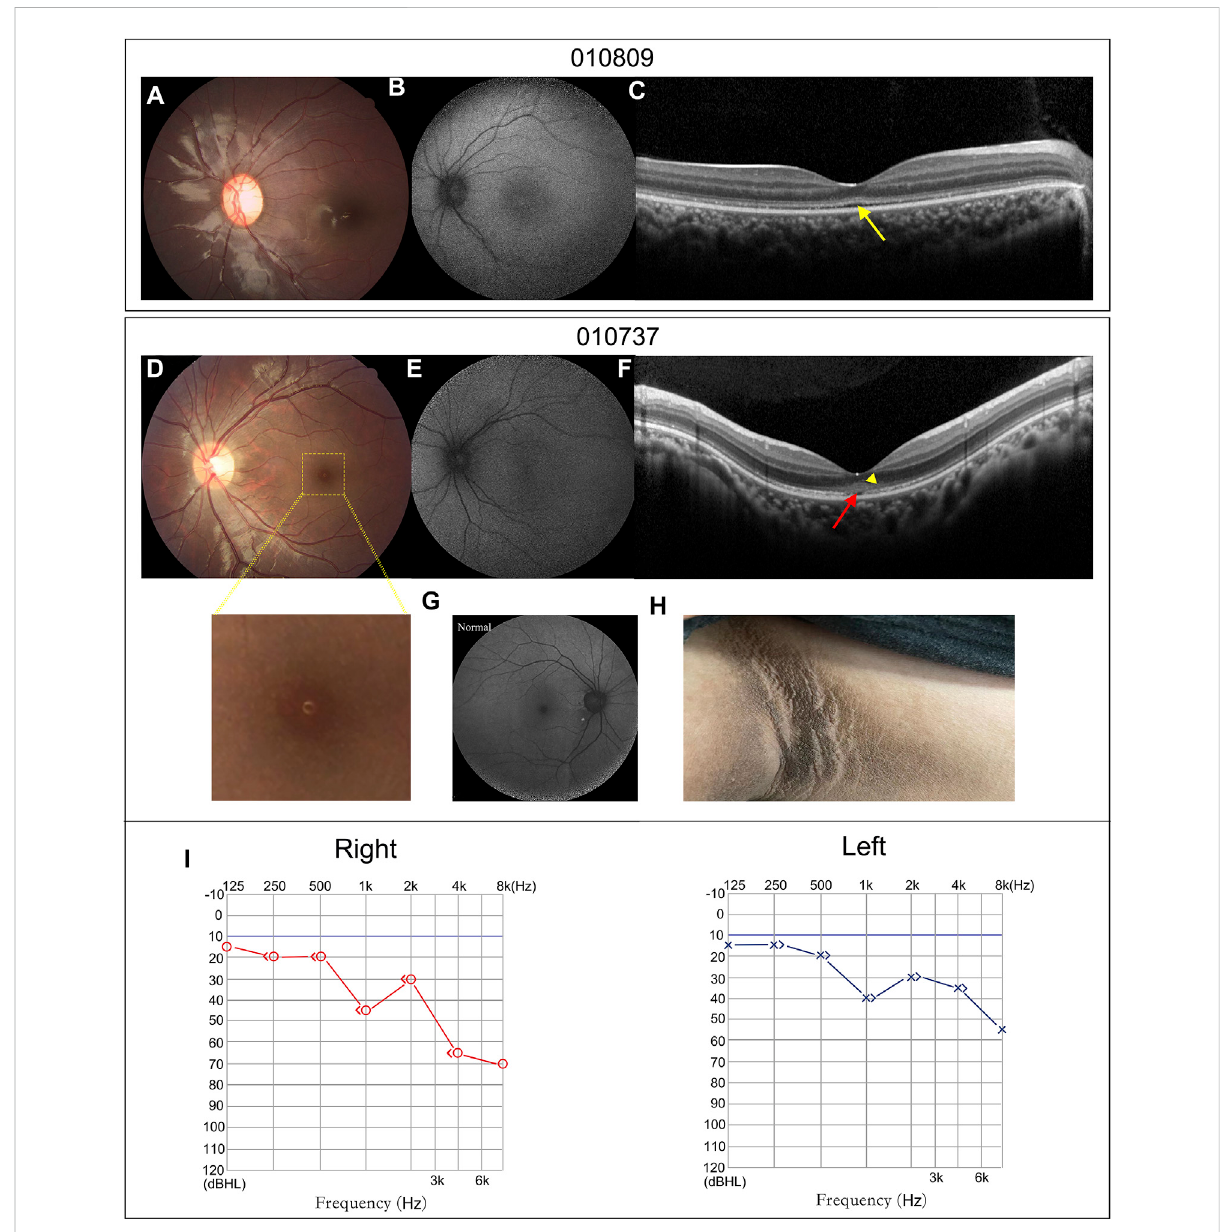
FIGURE 4 Atypical retinal features of patients 010809 and 010737, and systemic characteristics of patient 010737. (A,D) CF photographs exhibit atypical funduschangeswithgranular-likechangesinthemacula. (B,E) FAFimagesshowlossofthehypo-auto fl uorescenceinthefovea. (G) AFAFimageofa normal eye. (C,F) . OCT scans display coarse EZ (yellow arrow), EZ disruption in the fovea (red arrow) and moderately re fl ective materials in the outer nuclear layer (yellow triangle). (H) Patient 010737 showed acanthosis nigricans in the axillae. (I) The PTA of patient 010737 indicates moderate and mild sensorineural hearing loss in the right and left